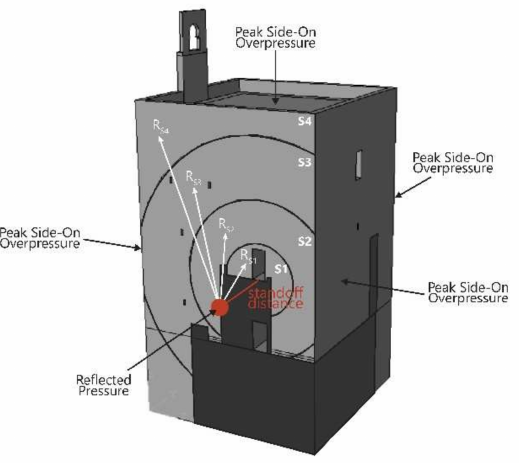
Figure 3. Locations of the blast on the exterior of the Torre de la Vela